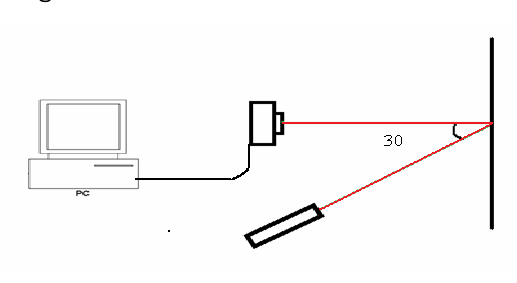
Fig.2: Optical arrangement of the experiment .